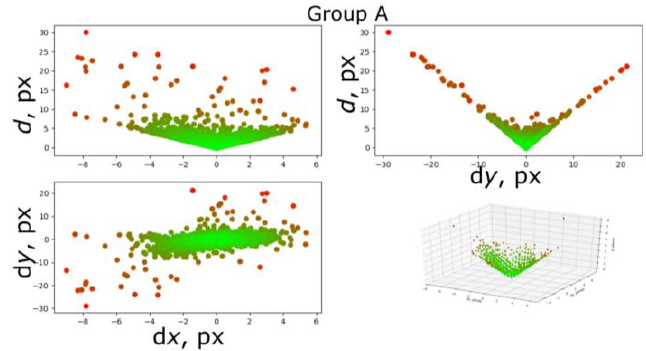
Fig. 8. Video 2, group A observations.